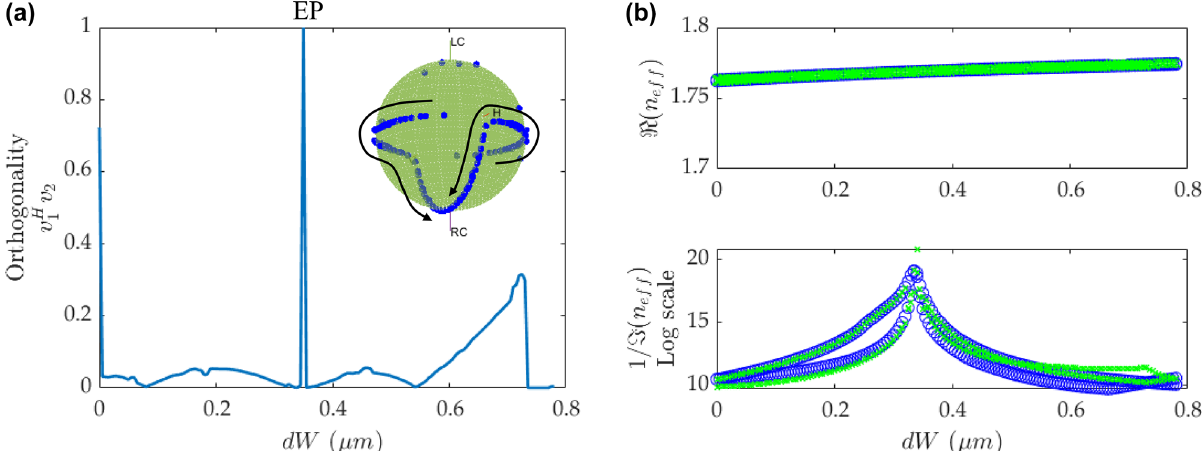
Figure 5: EPs at BICs. (a) The orthogonality versus d W with C = 1.17. Each two-row eigenvector can be deemed like a polarization state and mapped onto the Bloch sphere. At EP, with coalesced eigenstates, the two points will also coalesce on the Bloch sphere. The inset shows the corresponding evolution of the eigenvectors on the Bloch sphere. The imaginary part is magnified by a factor of 10 4 for better visualization. The arrow shows the corresponding evolution of eigenstates on the Bloch sphere. (b) The real and imaginary parts of n , obtained from the direct eigenmode simulation, and the green crosses show the calculated eigenvalues, obtained blue circles show the n eff from the Hamiltonian for the coupled waveguides.